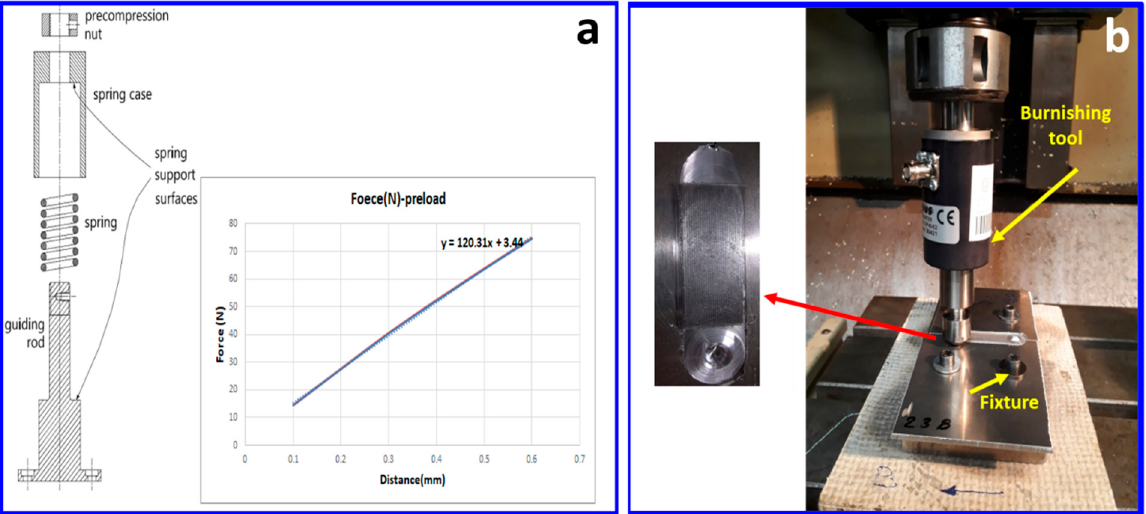
Figure 2. ( a ) Exploded view of BB tool [16]; ( b ) set up for BB process. Table 1. Standard chemical composition of AA2024-T3 alloy.